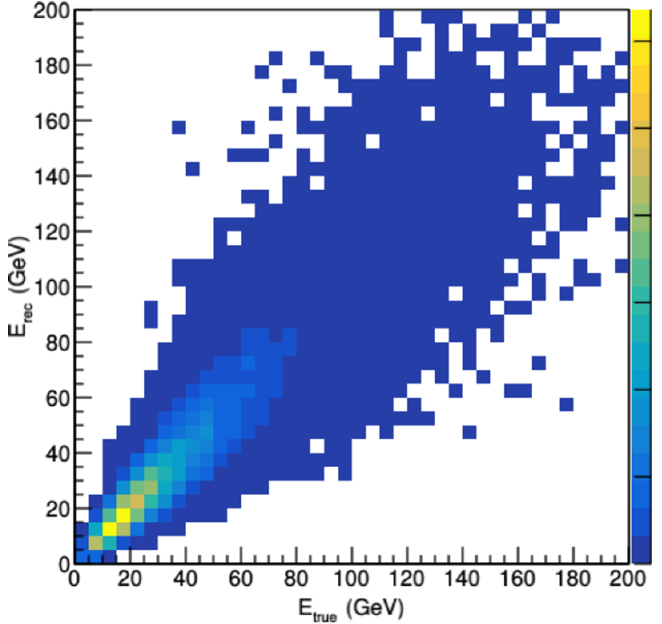
Figure 2 . Reconstructed versus MC energy for (cid:23) e CC events in the OPERA Target